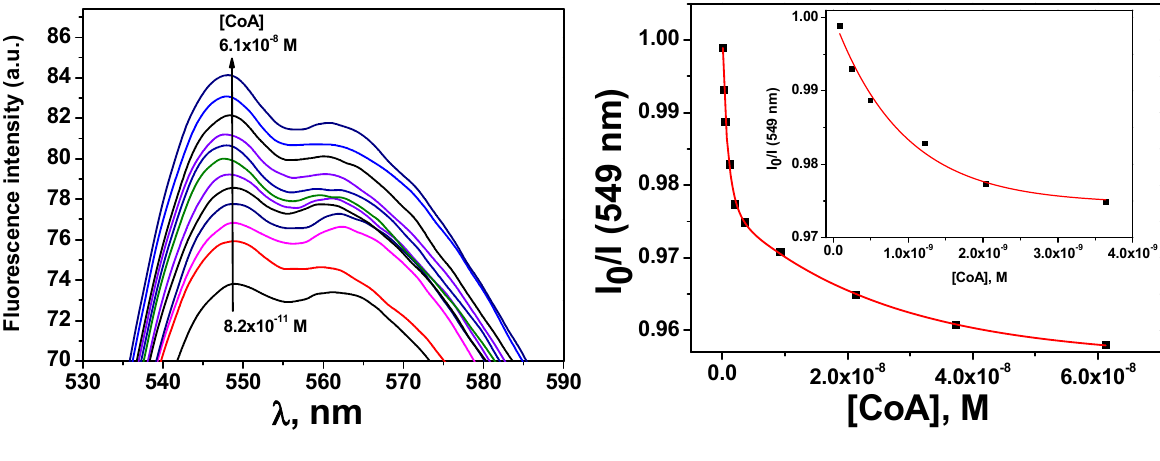
Figure 4. Selected fluorescence spectra (left) and titration curve (right) of M2 upon adding increasing quantities of CoA in water at physiological pH (pH = 7.4, TRIS) at an excitation wavelength of 400 nm. The inset for the figure on the right is an expansion of the lower concentrations of the titration